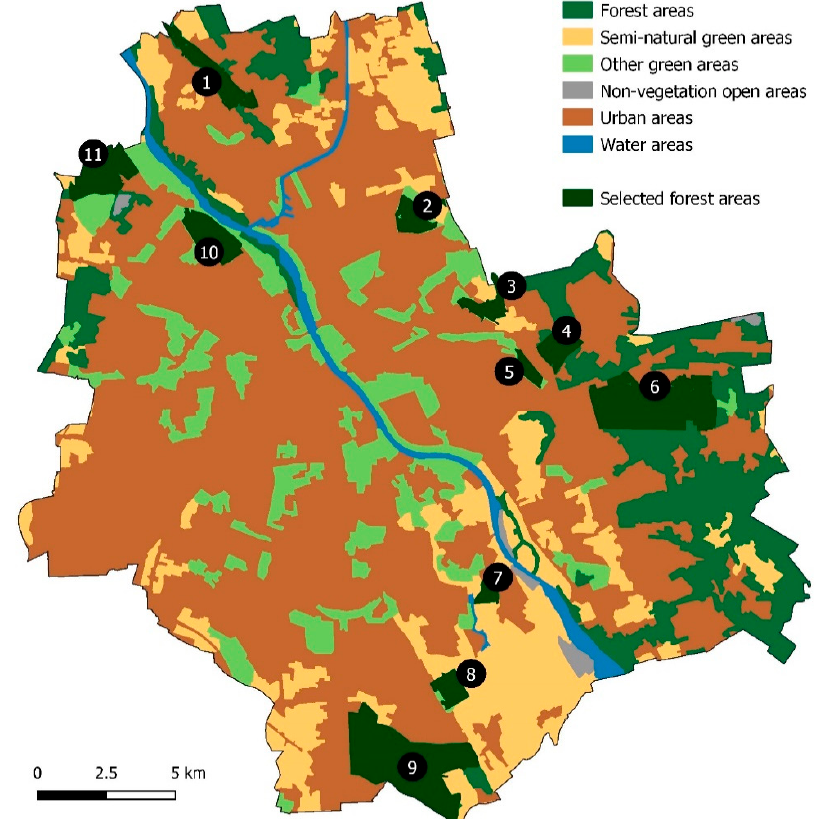
Figure 1. Distribution of urban forests in Warsaw where camera traps were set in the years 2019– 2020 to study roe deer activity patterns. The numbers show selected forest areas: 1. Henryków and D ą brówka Forest Park, 2. Bródno Forest Park, 3. Utrata Forest, 4. Kaw ę czyn Nature Reserve, 5. Olszynka Grochowska Nature Reserve, 6. Sobieski Forest (incl. Jan III Sobieski Nature Reserve), 7. Morysin Nature Reserve, 8. Natolin Forest Nature Reserve, 9. Kabaty Forest Nature Reserve, 10. Bielany Forest and 11. Młociny Forest. Types of land cover were taken from CORINE Land Cover [36]. Six types of land cover were distinguished: forest areas (all natural wooded areas), semi-natural green areas (arable land, pastures, heterogeneous agricultural areas, shrub and/or herbaceous associations), other green areas (artificial, non-agricultural vegetated areas and permanent crops), non-vegetation open areas (open spaces with little or no vegetation, mine, dump and construction sites), urban areas (urban fabric, industrial, commercial and transport units) and waters (water bodies).